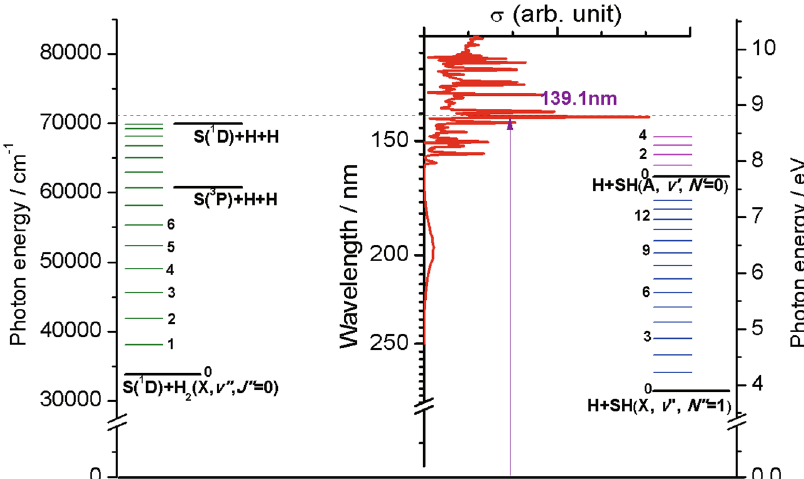
Fig. 1 Overview of photodissociation processes of H 2 S at λ ~139.1 nm. Overview of the H 2 S parent absorption spectrum (the red curve, plotted as cross- section σ versus UV wavelength in nm, adapted from ref. 22 ) along with the corresponding vertical excitation energies in cm − 1 and eV (left and right-hand scales, respectively) illustrating the various dissociation limits and the threshold energies for forming SH(X), SH(A) and H 2 (X) products in their different vibrational ( v ) states (shown, respectively, by the blue, cerise and green horizontal lines). The purple arrow displays the photo-excitation process and the dashed purple line represents the energy level of 139.1